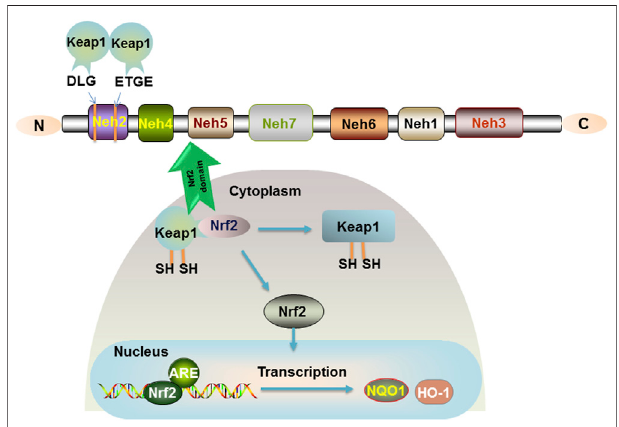
FIGURE 1 | Nrf2 signaling pathway. The relative positions of the Neh domains of transcription factor Nrf2 are shown. The Neh2 structural domain containing multiple lysine residues at the N terminus is present with a high af fi nity of ETGE motifand alower af fi nity of DLG motif. Keap1 is asparse group-rich protein that inhibits Nrf2. Keap1 degrades Nrf2 through polyubiquitination and phosphorylation modi fi cation of Nrf2. In the organism, Nrf2isboundtothecytoplasmbyKeap1,andonlywhenthecysteineresidues of Keap1 are modi fi ed to cause conformational changes, Nrf2 is released into the nucleus and binds to the ARE to promote the expression of the target genes NQO1 and HO-1.